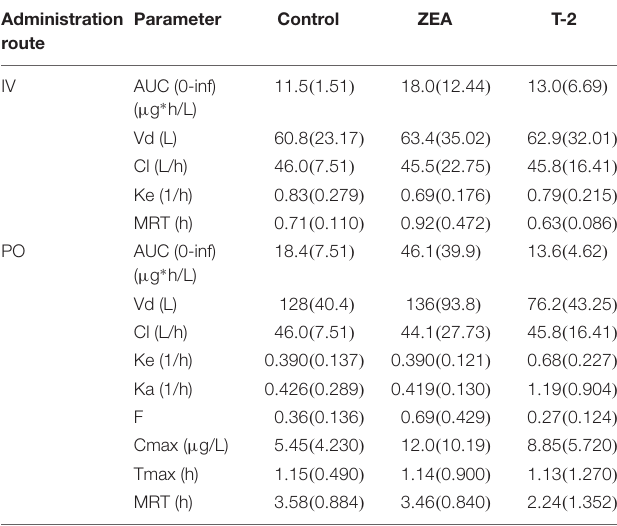
TABLE 3 | PK parameter estimates obtained by non-compartmental analysis after IV dosing of midazolam (0.036 mg/kg BW) and PO dosing of midazolam (0.15 mg/kg